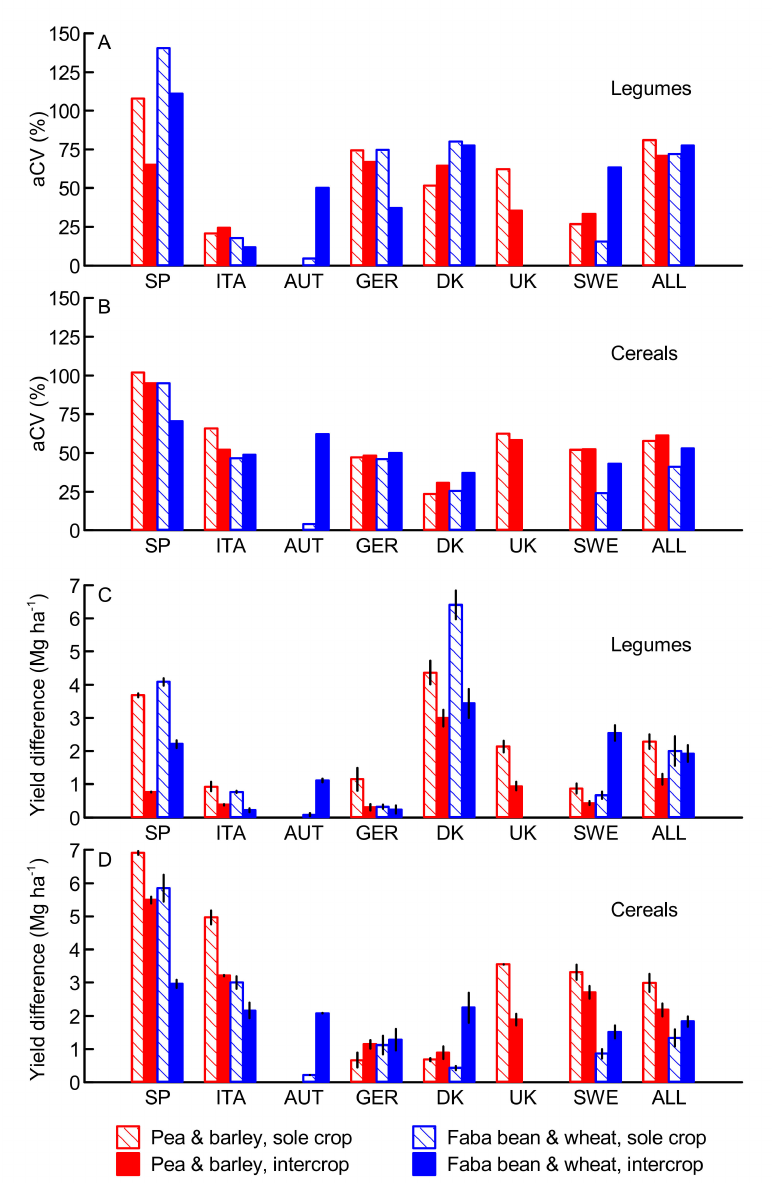
Figure 3. Single crop-based yield stability indices calculated on basis of adjusted coefficients of variance (aCV) ( A , B ), and yield differences (Delta, means ± SE) between the two cultivation years 2017 and 2018 ( C , D ), for various barley-pea and wheat-faba bean trials cultivated in seven sites across Europe. The bars in ( A , C ) represent either pea (red) or faba bean (blue) grown as sole crops or in the intercrop; and the bars in ( B , D ) represent either barley (red) or wheat (blue) grown as sole crops or in the intercrop. SP Spain, ITA Italy, AUT Austria, GER Germany, DK Denmark, UK United Kingdom, SWE Sweden, ALL calculations across all